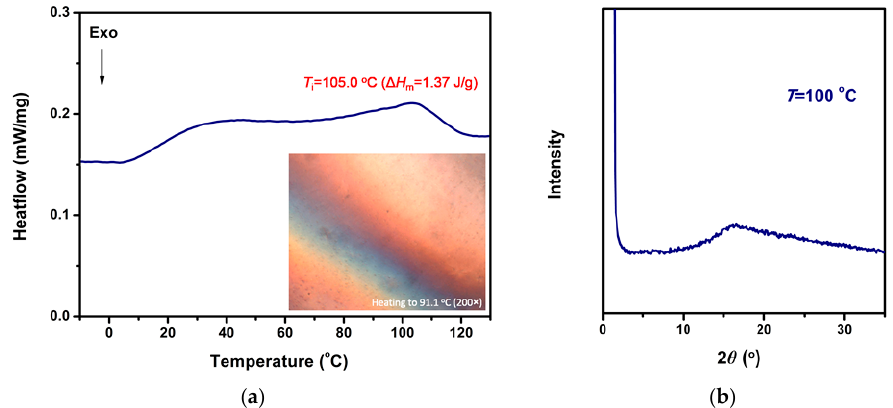
Figure 2. ( a ) Differential scanning calorimetry (DSC) curves of mPEG 43 -PMCC 25 -P(MCC-DHO) 15 , the inset at lower right is photograph on heating to 91.1 °C recorded by polarizing optical microscopy (POM); ( b ) X-ray diffraction (XRD) curve of mPEG 43 -PMCC 25 -P(MCC-DHO) 15 at 100 °C.